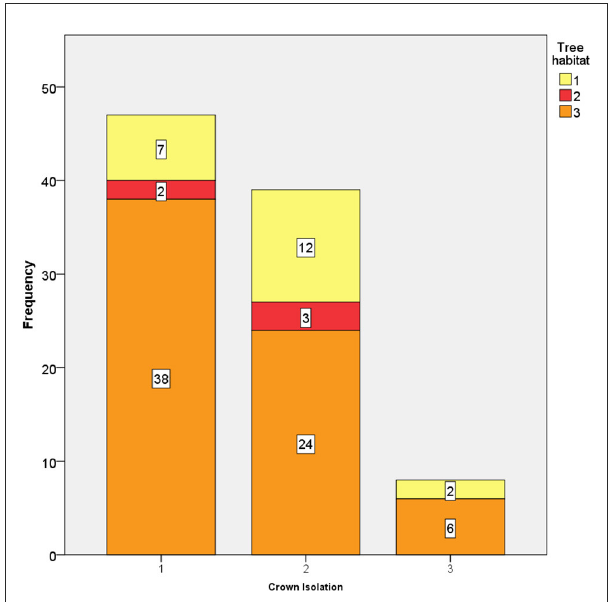
FIGURE6 Natural regeneration tree classification (NRTC) tree habit results of NR according to crown isolation.